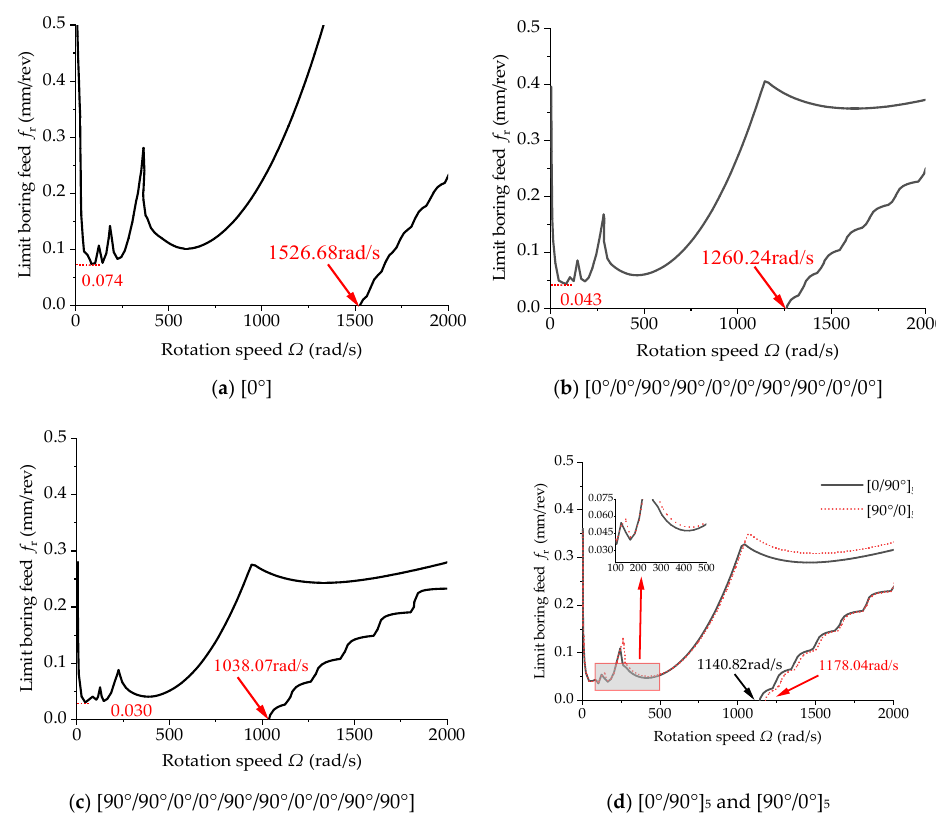
Figure 17. Effect of the ply angle on the stability of the boring bar ( ψ = 1, TR = 0 and L = 2